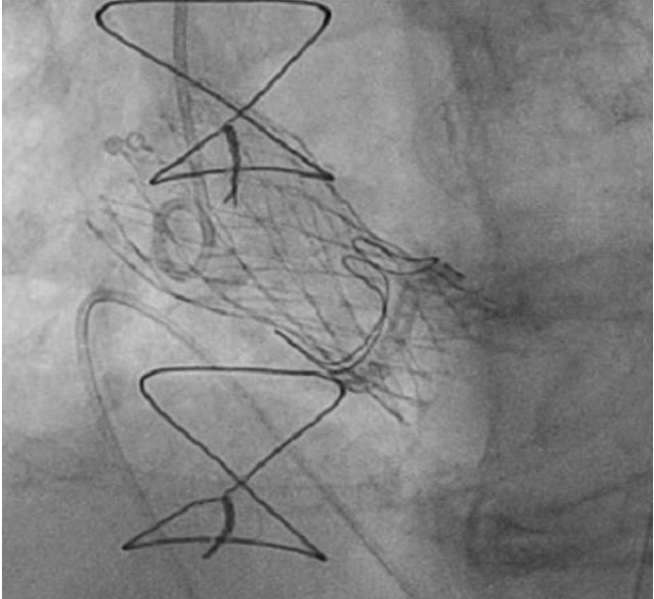
Figure 6. Post-implantation valve-in-valve view of a Corevalve Evolute R 26 mm inside a degenerated Sorin Mitroflow 23 mm.